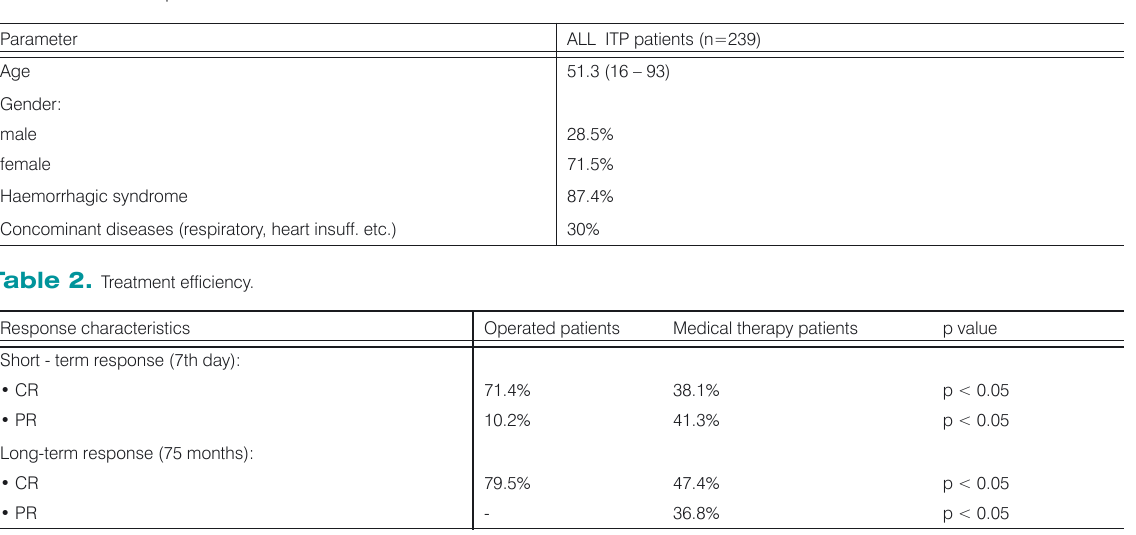
Table 1. General patient characteristics.